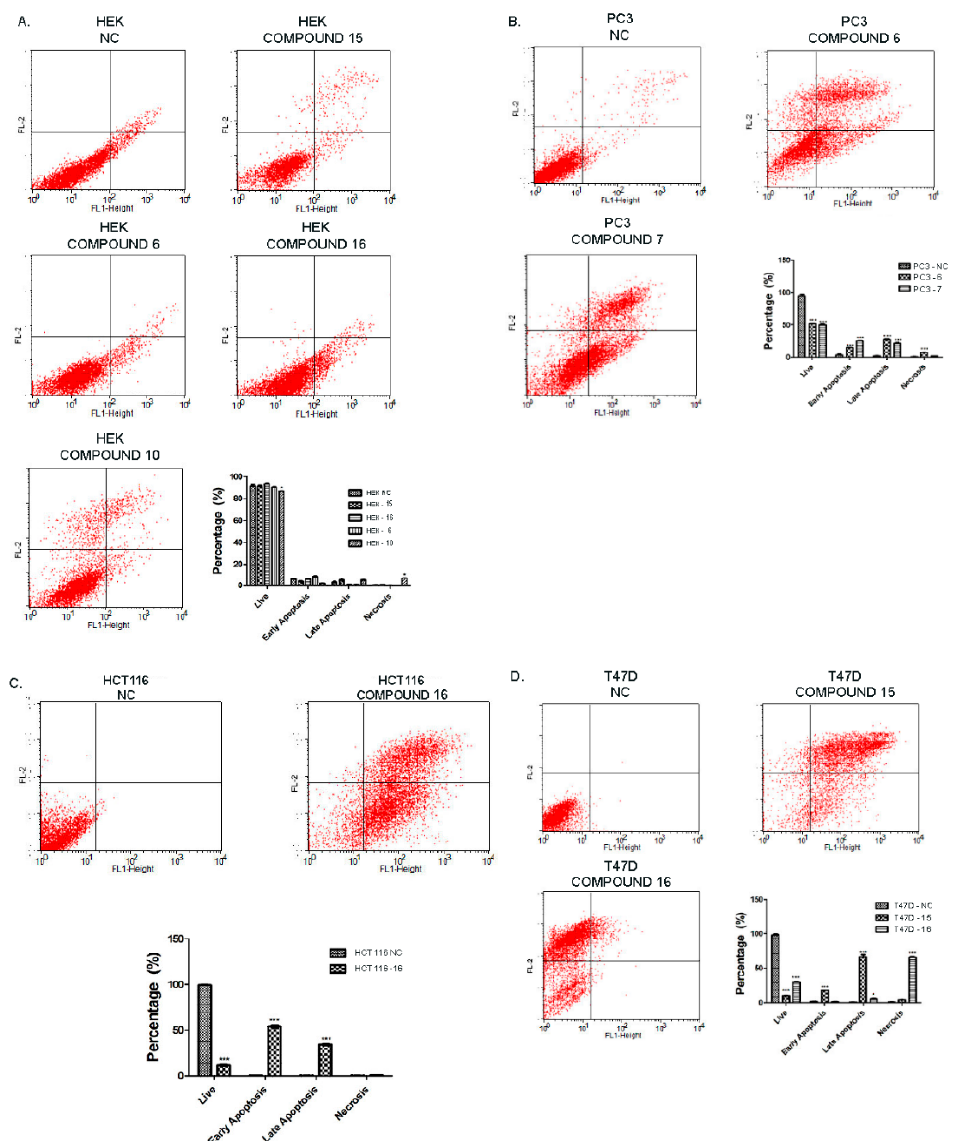
Figure 3. Determination of apoptosis and necrosis potential of synthesized compounds on HEK293, PC-3, HCT116 and T47D cell lines. ( A ) Compounds tested on HEK293 cell line did not exhibit any cytotoxic effects, except compound 10 with a slight insignificant increase in necrosis; ( B ) Treatment of PC-3 cells with compounds 6 and 10 resulted in increase of late apoptosis markers; ( C ) Compound 16 displayed extensive apoptotic effects (both early and late markers were elevated) on the HCT116 cancer cell line; ( D ) T47D cancer cells underwent vast late apoptosis through the treatment with compound 15 , whereas compound 16 caused necrosis of T47D cancer cells (* p < 0.05, ** p < 0.01, *** p < 0.001).